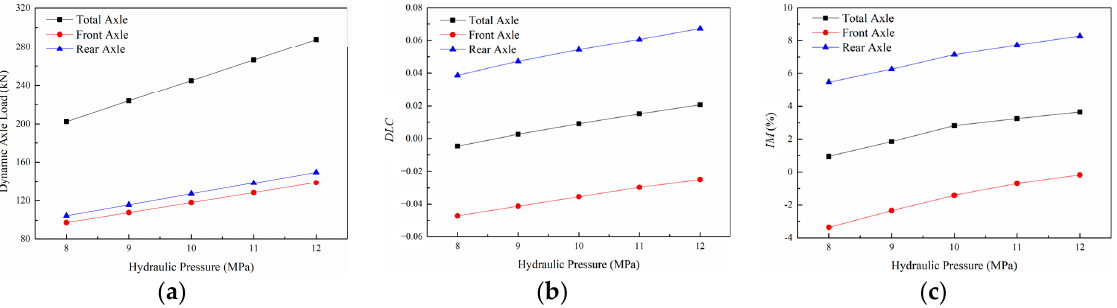
Figure 17. Dynamic axle load in curved road sections with different hydraulic pressure under simulation conditions. ( a ) Dynamic axle load. ( b ) DLC . ( c ) IM